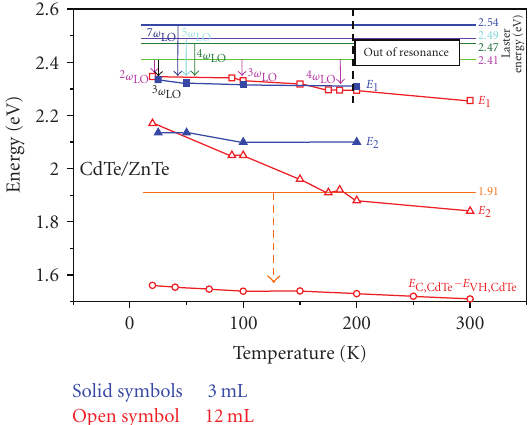
Figure 4: Temperature dependences of PL emission peaks and schematic presentation of multiphonon (MP) resonance. Results for 3ml sample are presented as open symbols, and for 12 mL sample as solid symbols .